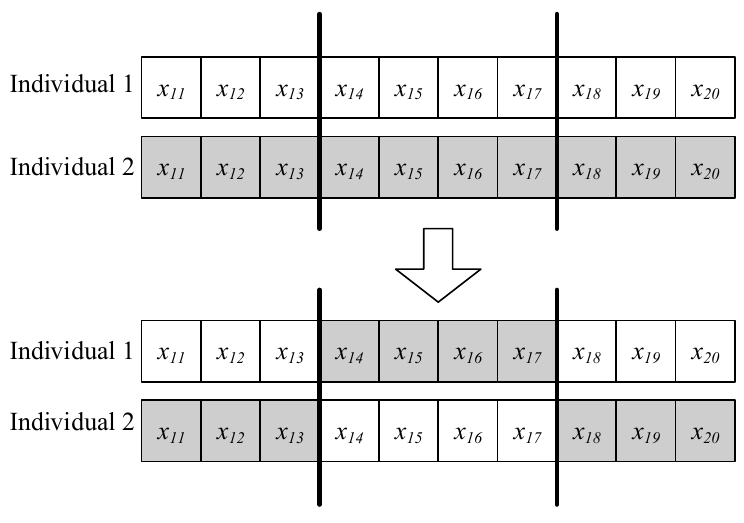
Figure 7. Two-point crossover operation.